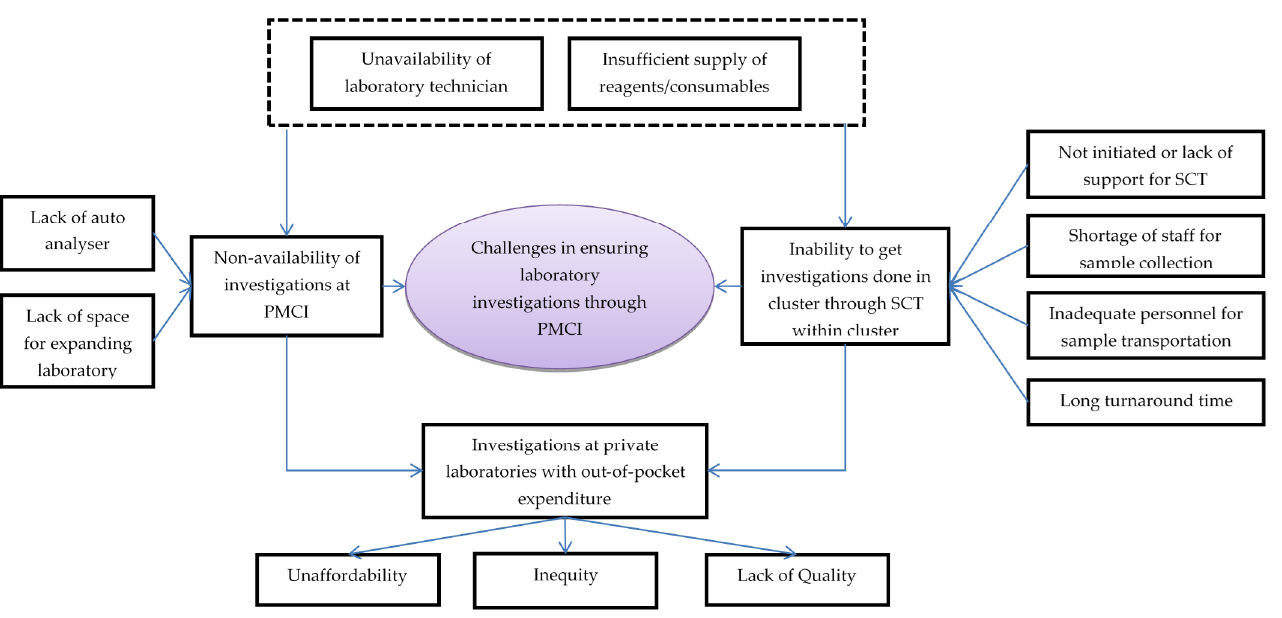
Figure 4. Challenges in laboratory investigations conducted through PMCI supported by PSSP in Sri Lanka, 2021. Abbreviation: PMCI: Primary Medical Care Institution; PSSP: Primary Healthcare- System-Strengthening Project (PSSP); SCT: Sample collection and transportation.